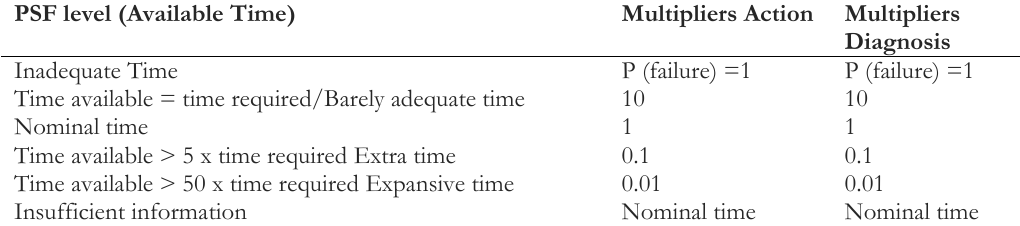
Table 1. The PSF weight for available